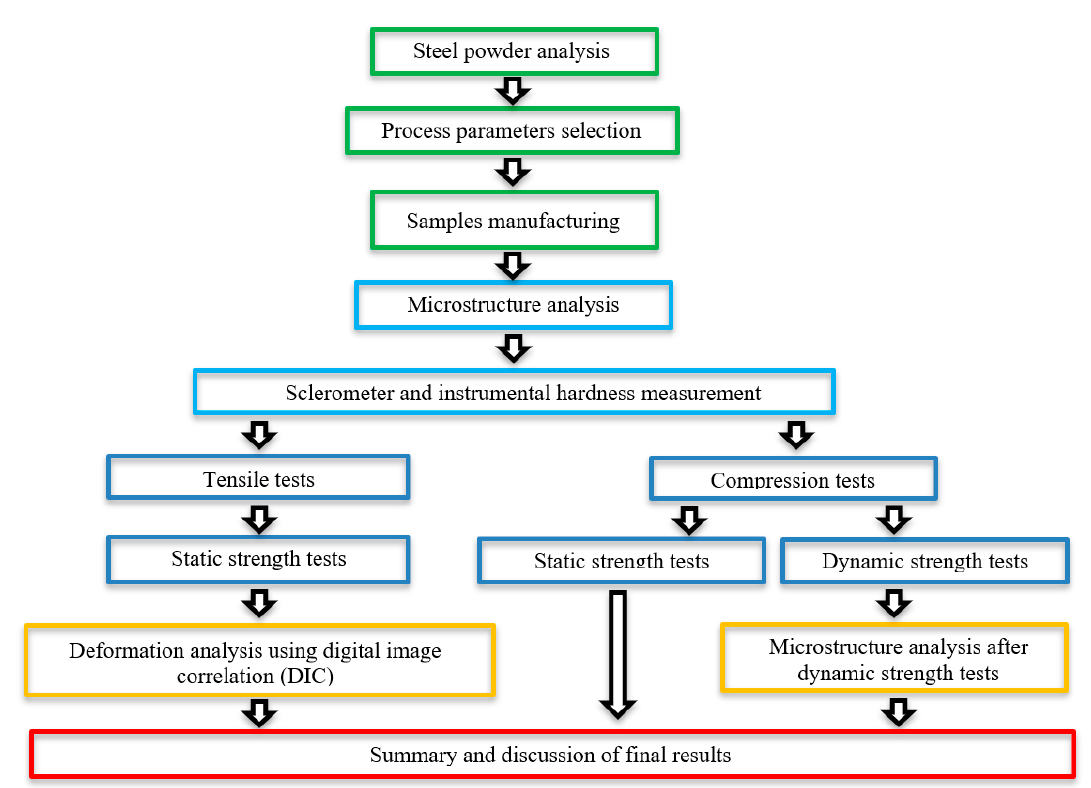
Figure 1. Illustration of the research methodology employed in this study.